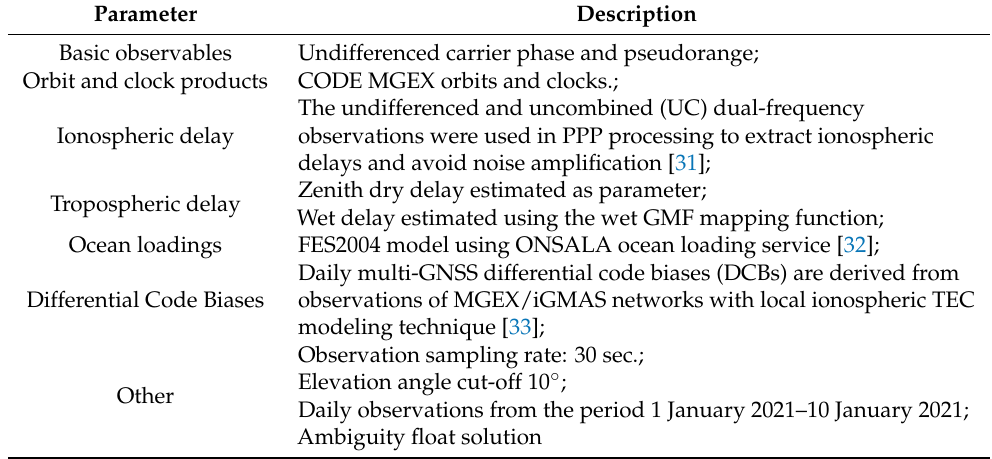
Table 3. GAMP processing